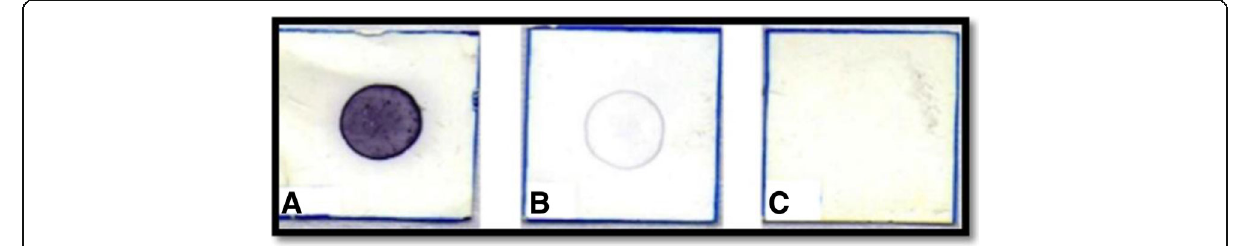
Fig. 1 Reactivity pattern of Dot-ELISA assay: ( a ) positive reaction, ( b ) undetermined reaction and ( c ) non-reactive result